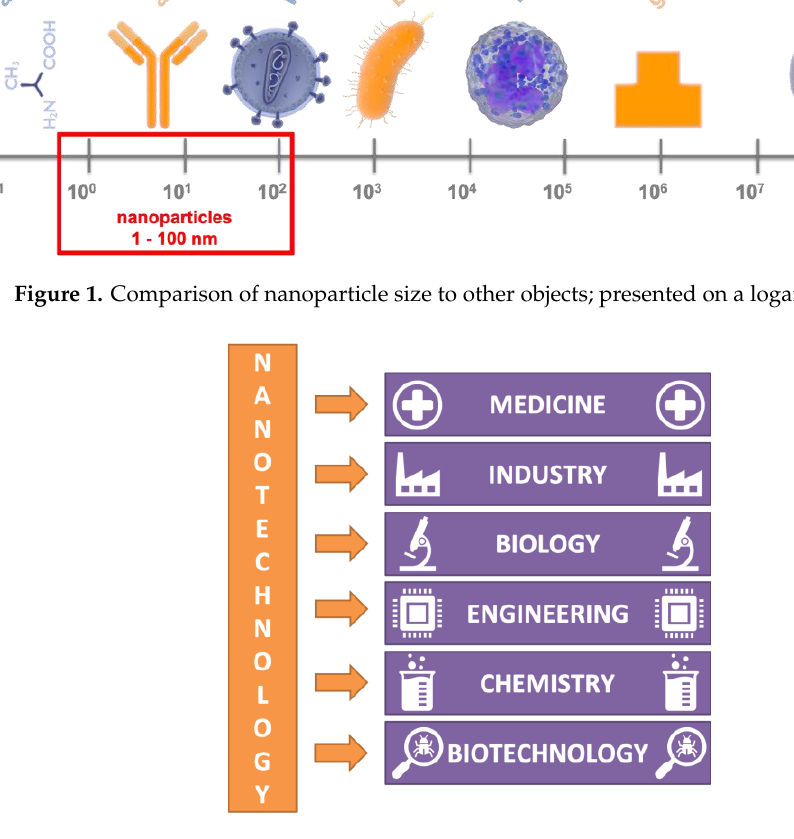
Figure 2. Applications of nanotechnology.